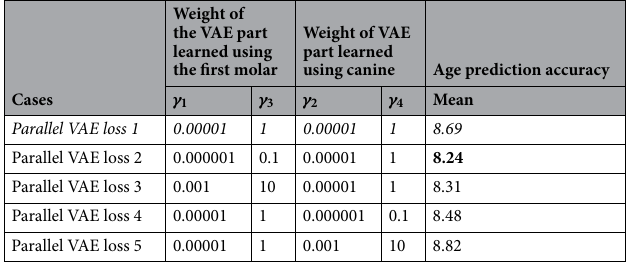
Table 2. Five combinations of weight values for training with the first molar and canine to study the effects on parallel VAE loss values. Significant values are in bold and italics.